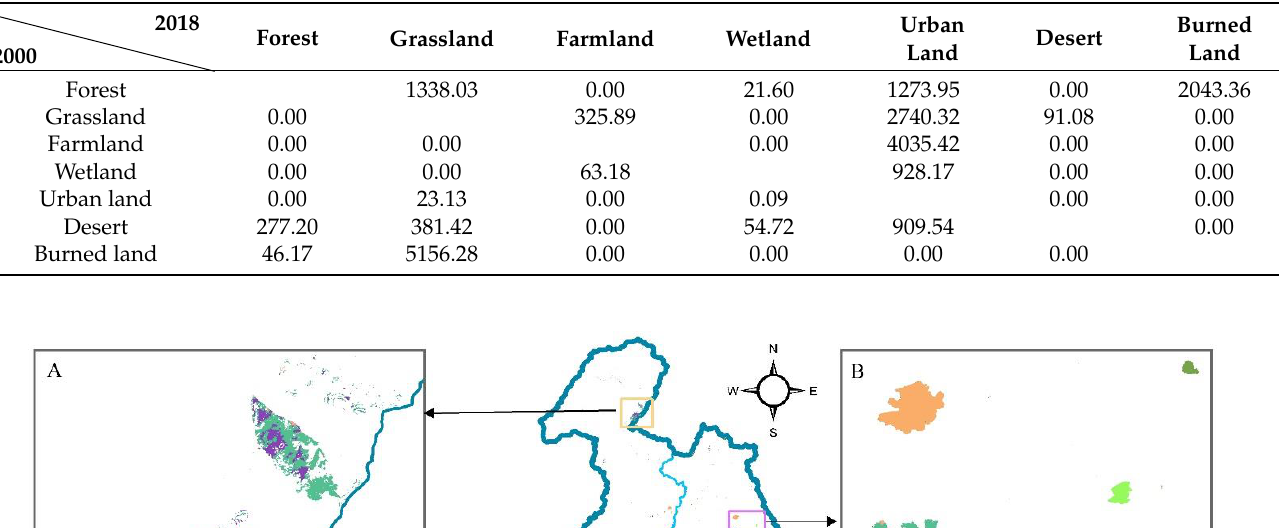
Table 4. Land cover transition matrix from 2010 to 2018 (hm 2 ).